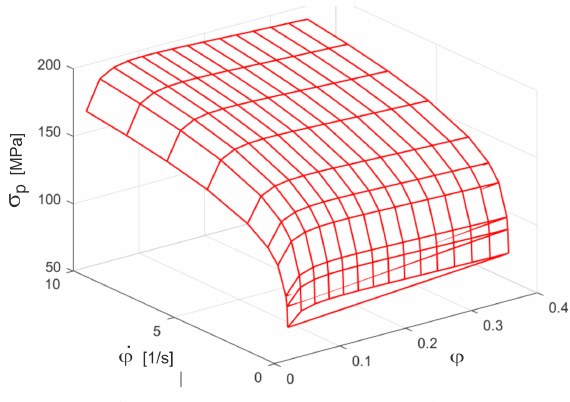
Figure 3: Curves of the predicted hot flow stress σ p as a function of true strain ϕ and strain rate ˙ φ for constant deformation temperature T = 900 ∘ C